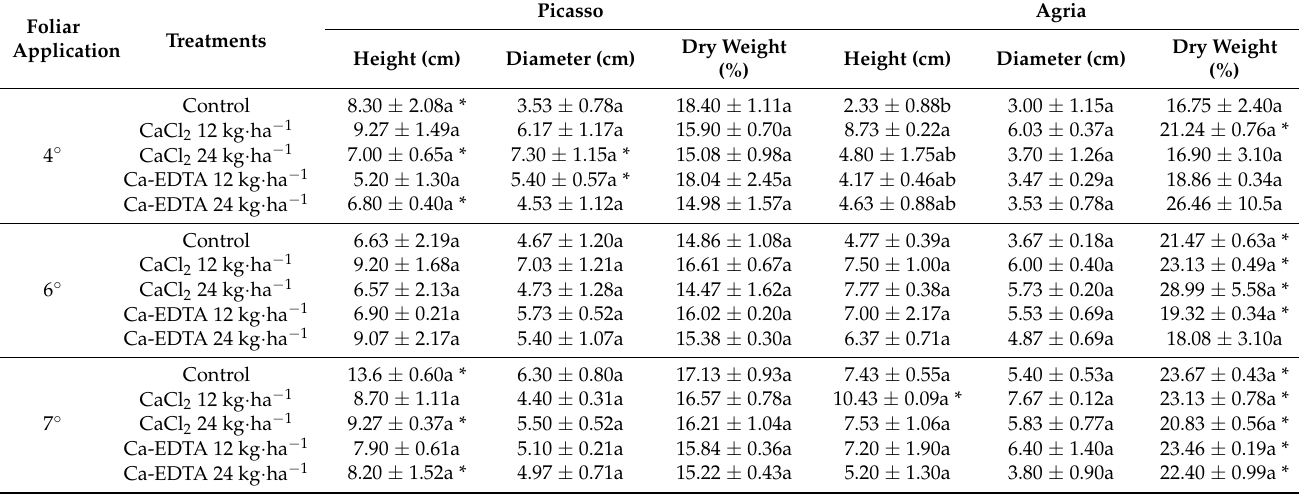
Table 1. Height, diameter, and dry weight of the tubers of the S. tuberosum L. Picasso and Agria varieties after the fourth, sixth, and seventh foliar application with CaCl 2 (12 and 24 kg · ha − 1 ) and Ca-EDTA (12 and 24 kg · ha − 1 ). For each parameter and foliar application, the different letters after the mean values ± S.E. ( n = 4) express significant differences between the treatments within each variety (a,b). Significant higher content between varieties within each treatment after the fourth (4FA), sixth (6FA), and seventh (7FA) foliar application is identified